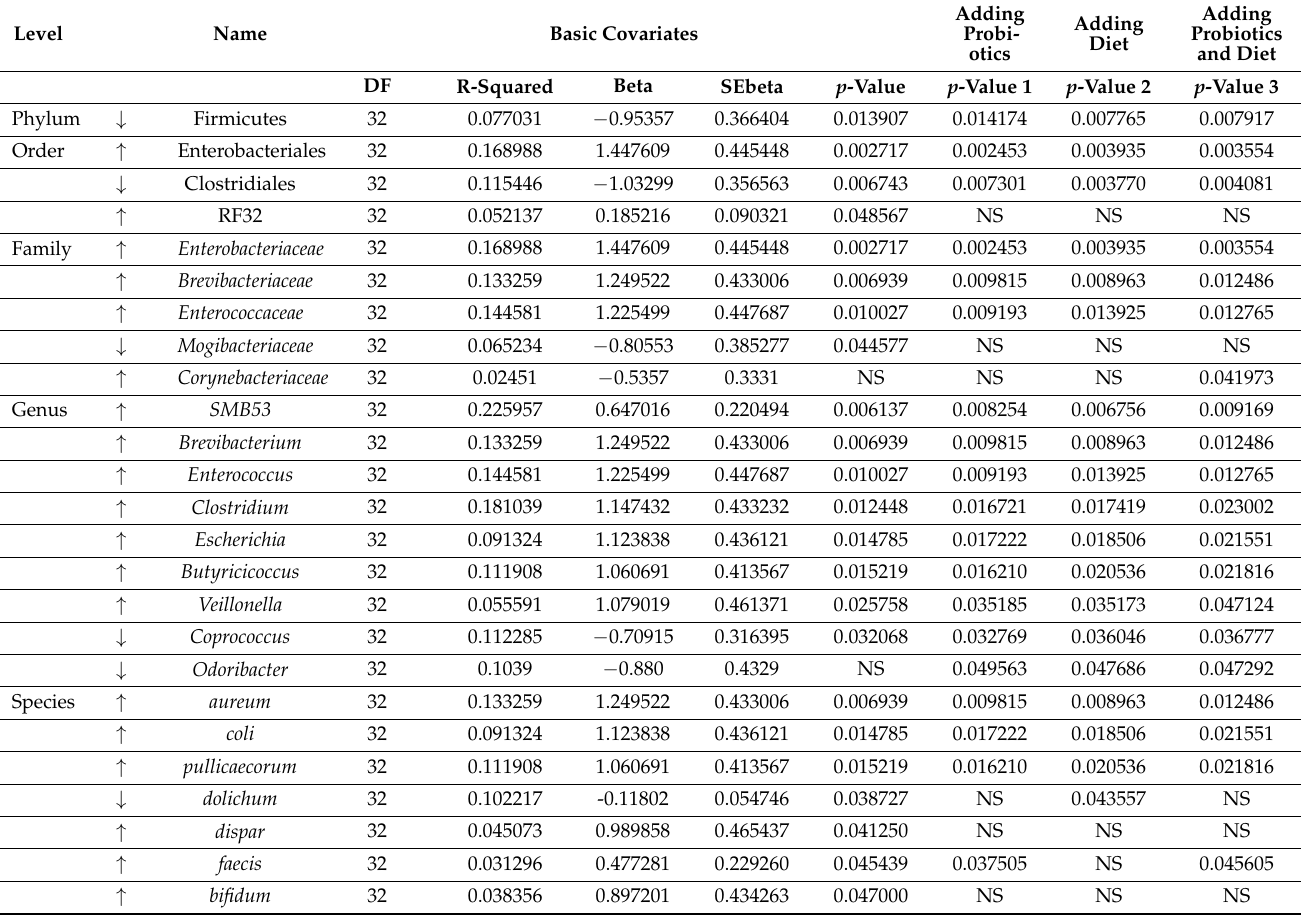
Table 4. Significant relative abundances of bacterial taxa in NDD compared to